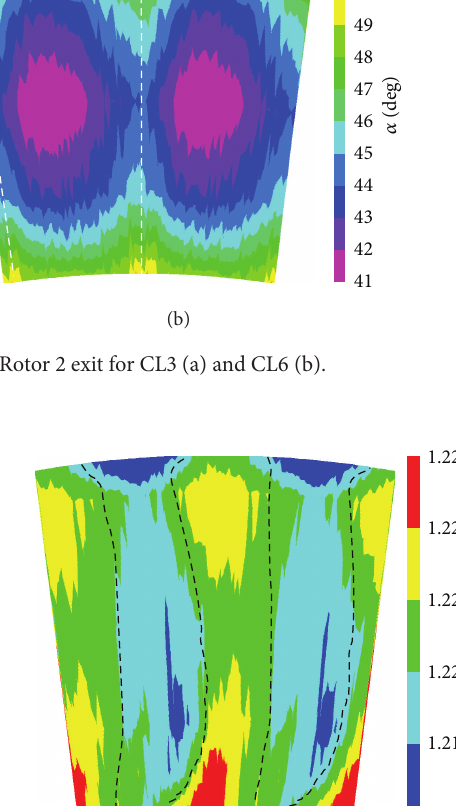
leading edge. The axial distance between the probe and the downstream vane leading edge is less than 15%c. These data were acquired with cross-film thermal anemometry